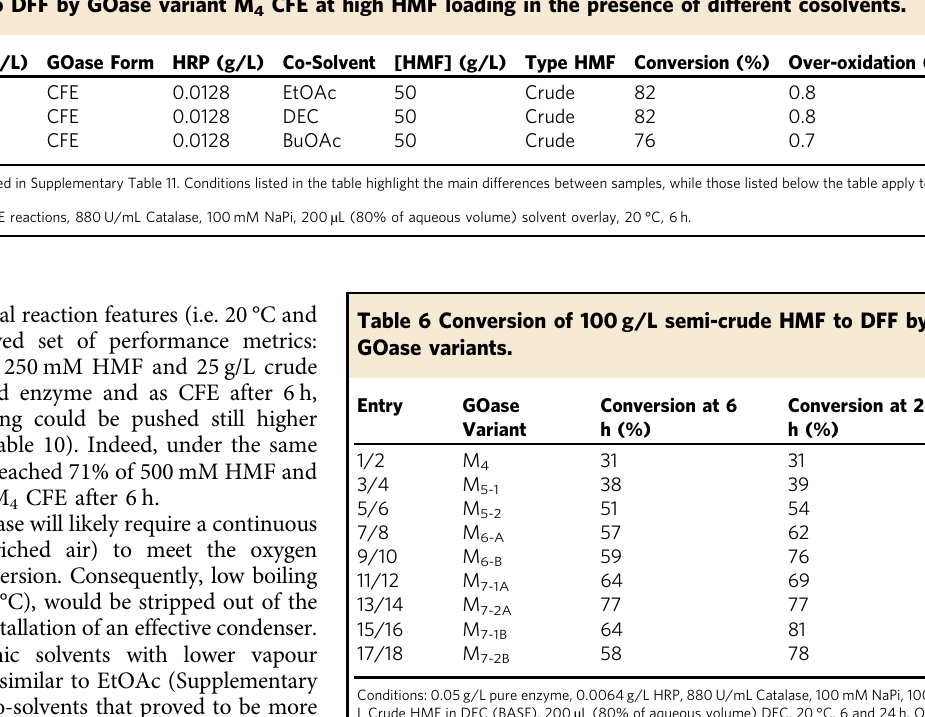
Table 5 Conversion of HMF to DFF by GOase variant M 4 CFE at high HMF loading in the presence of different cosolvents. Entry GOase Variant GOase (g/L) GOase Form HRP (g/L) Co-Solvent [HMF] (g/L) Type HMF Conversion (%) Over-oxidation (%)